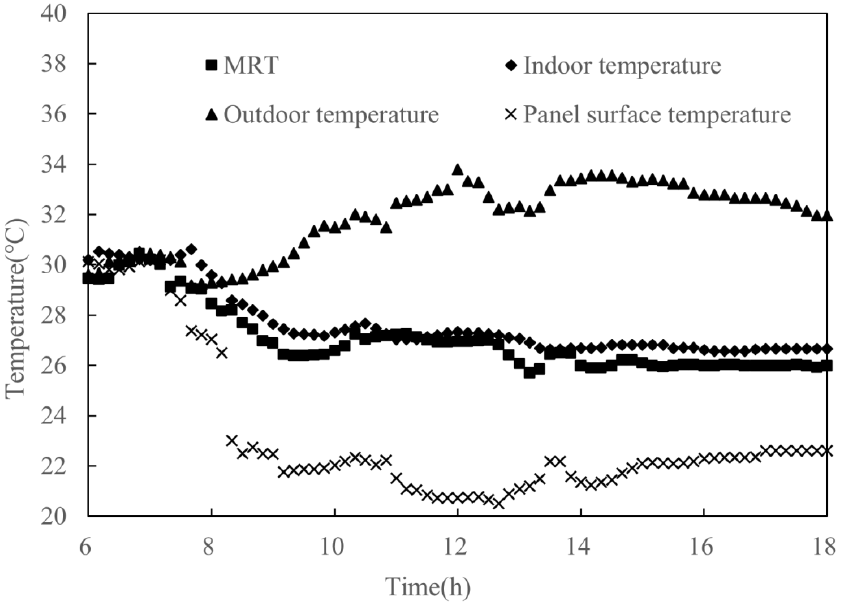
Figure 14. Variation process of MRT, indoor temperature, and surface temperature of radiant panel with time, under constant flow control.